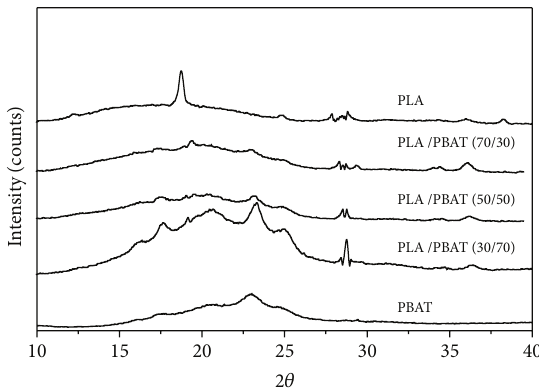
Figure 4: WAXD patterns of the untreated P LA/PBAT blends.